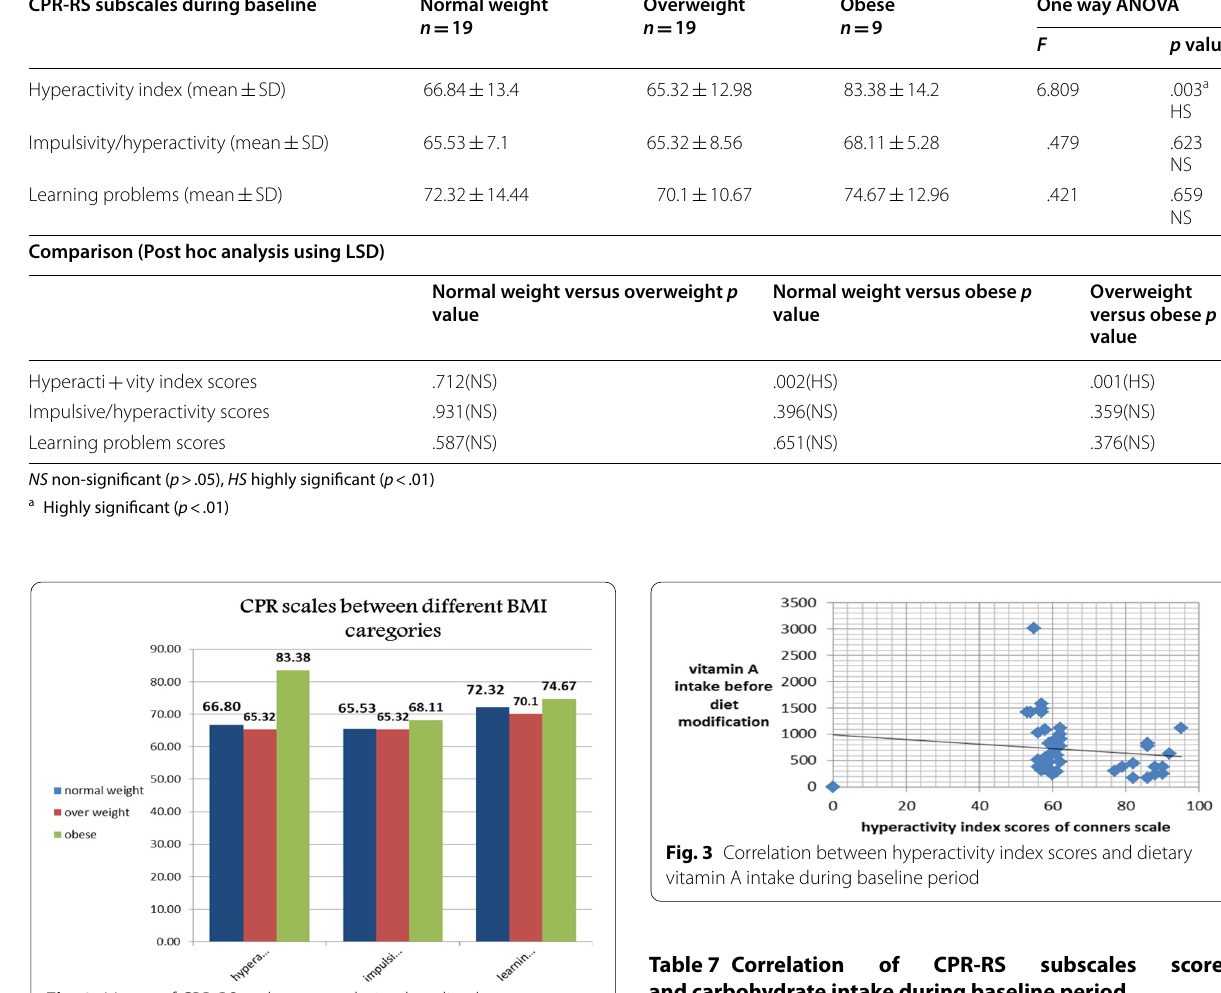
Table 5 Comparison of CPR scores between patients of different BMI categories during baseline period